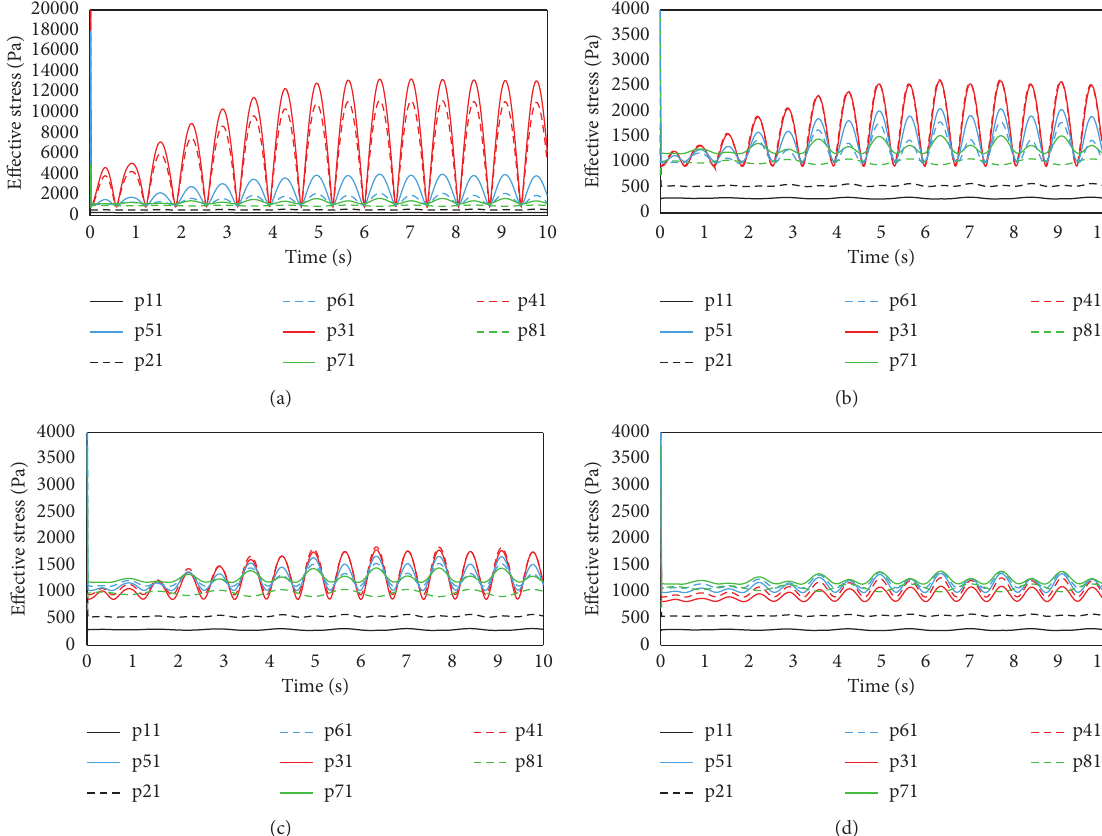
Figure 22: Comparison of effective stress in the vertical direction of different radian baffles: (a) r � 0.132m, (b) r � 0.136 m, (c) r � 0.140m, and (d) r �